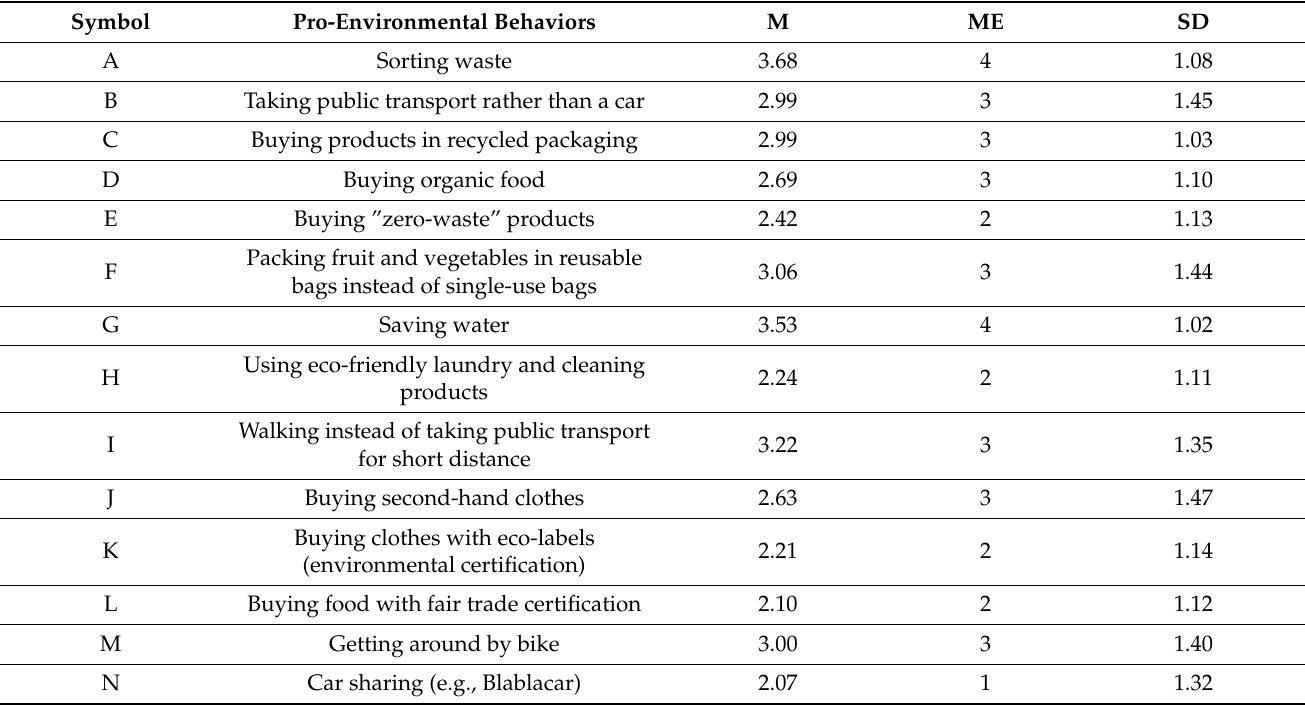
Table 2. Respondents’ evaluation of their own pro-environmental behaviors on a five-point Likert scale. Symbol